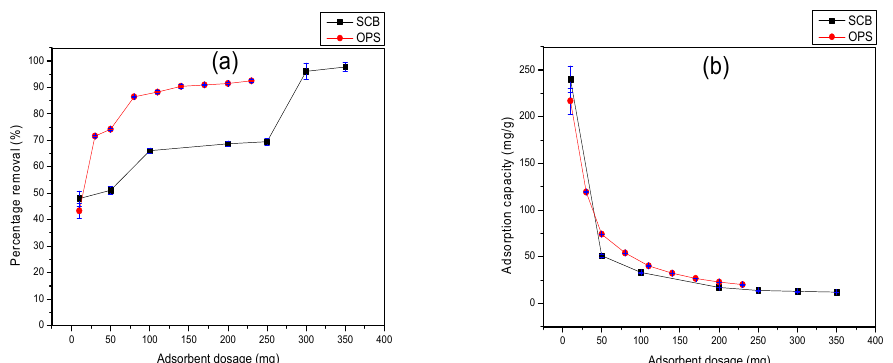
Figure 11. Effect of adsorbent dosage: ( a ) 50 mg/L Pb(II) percentage removal and ( b ) 50 mg/L Pb(II) adsorption capacity.